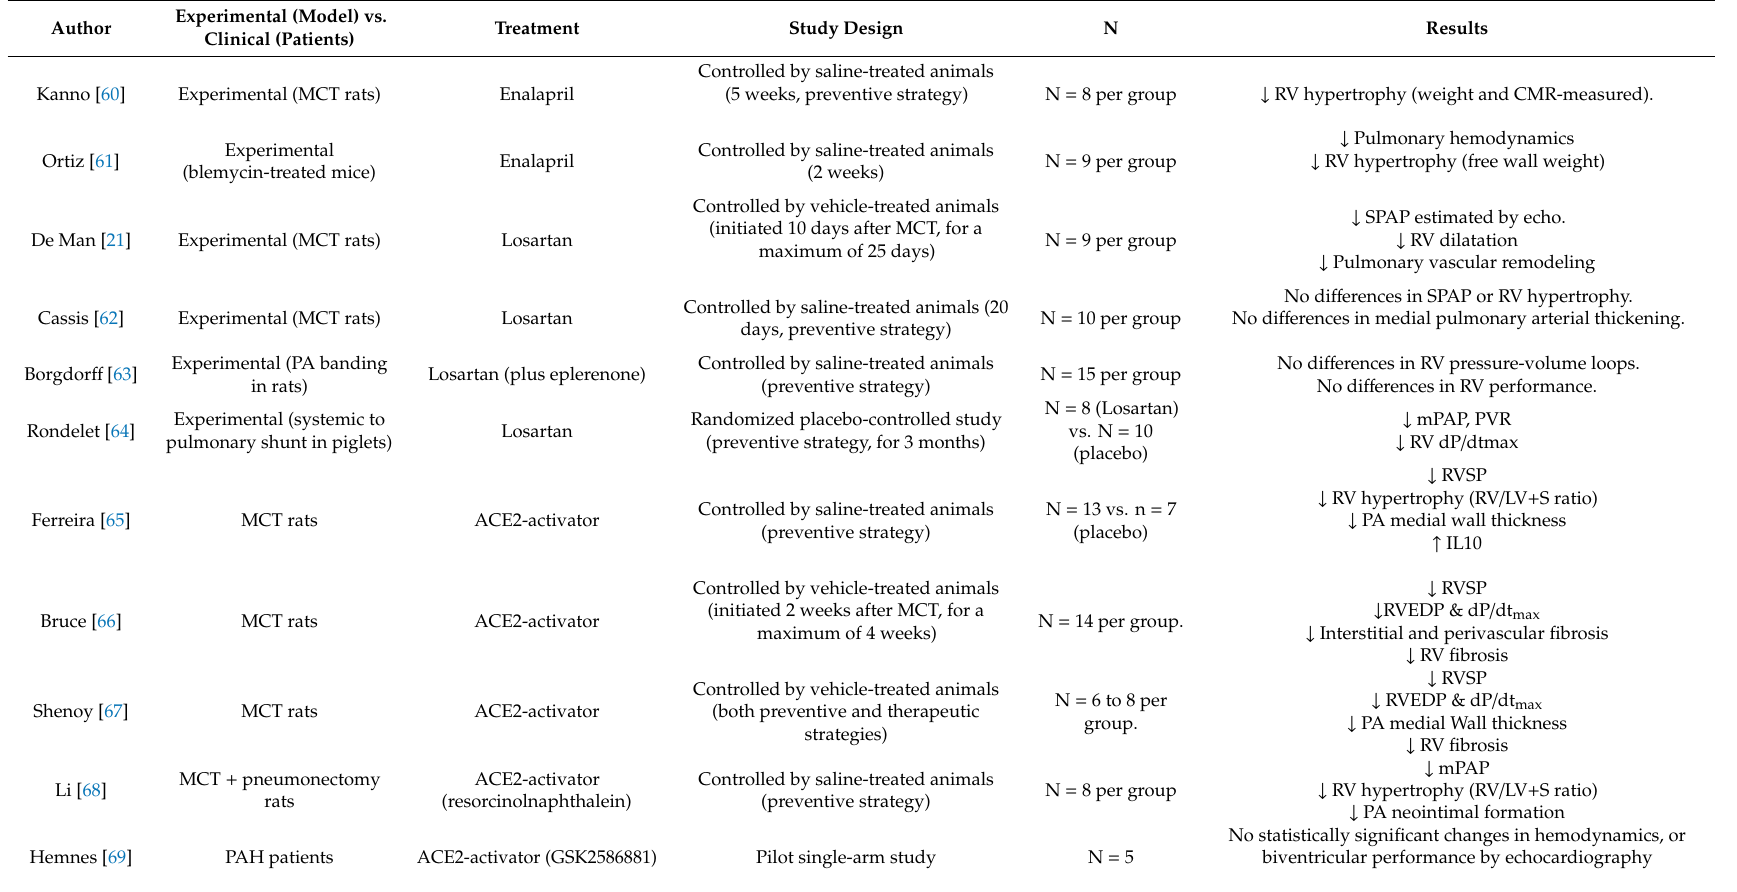
Table 2. Drugs targeting RAAS in